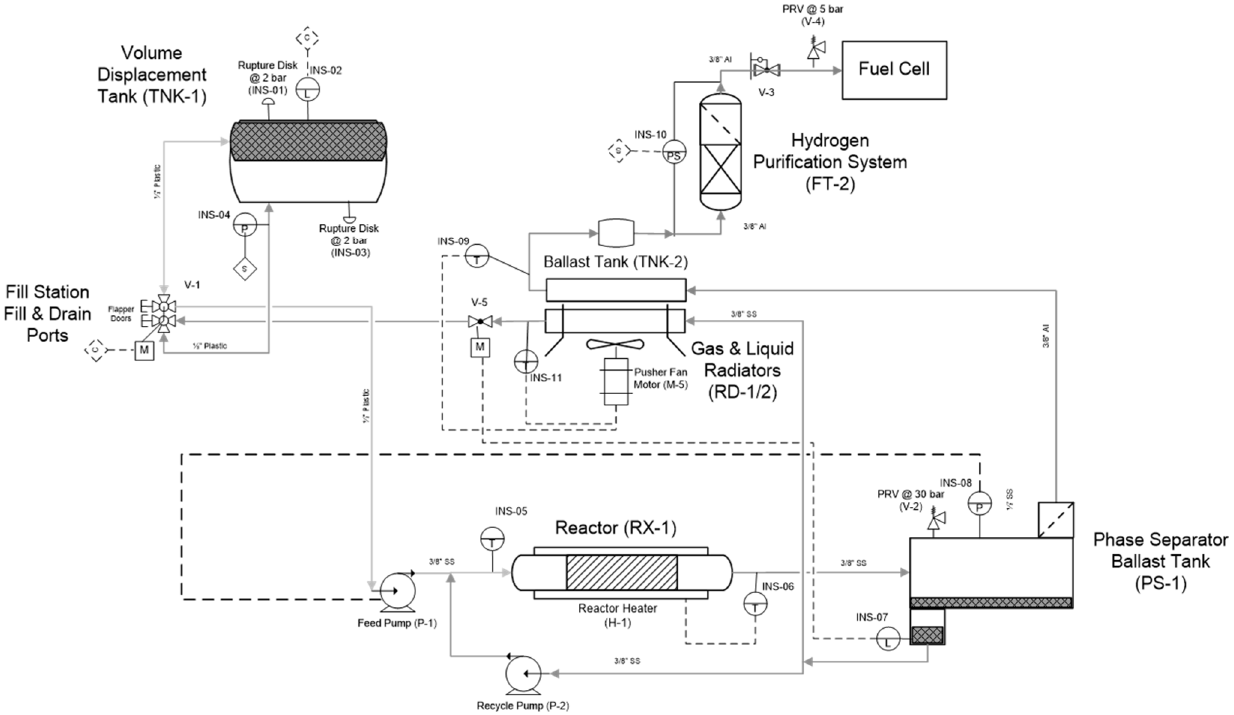
Figure 29. Automotive system design for off-board regenerable chemical hydrogen storage media [2].